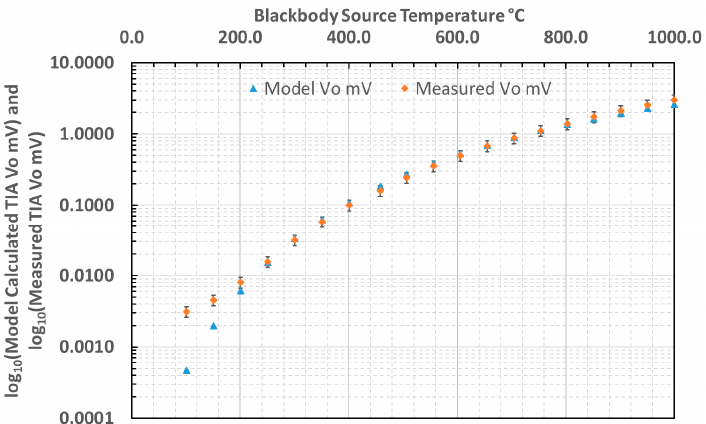
Figure 10. Comparison of calculated and measured output from our thermometer.